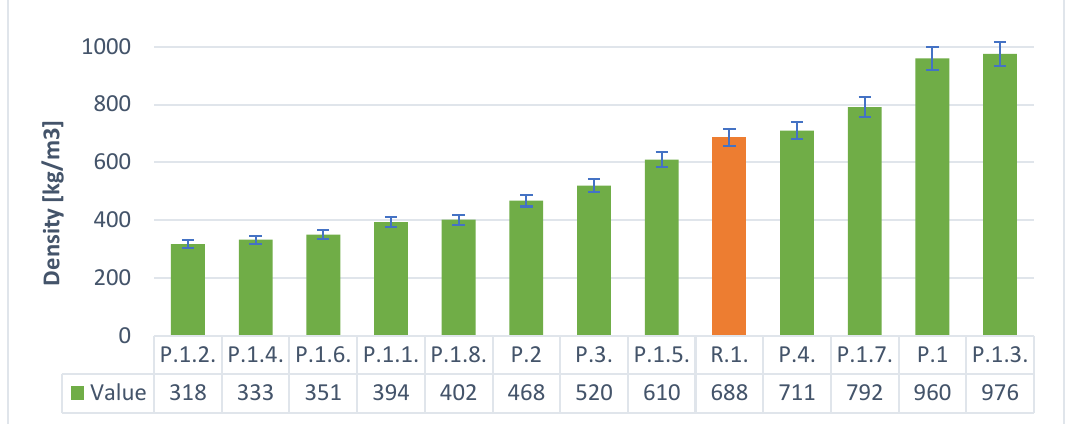
Figure 8. The density of samples with H 2 O 2 .